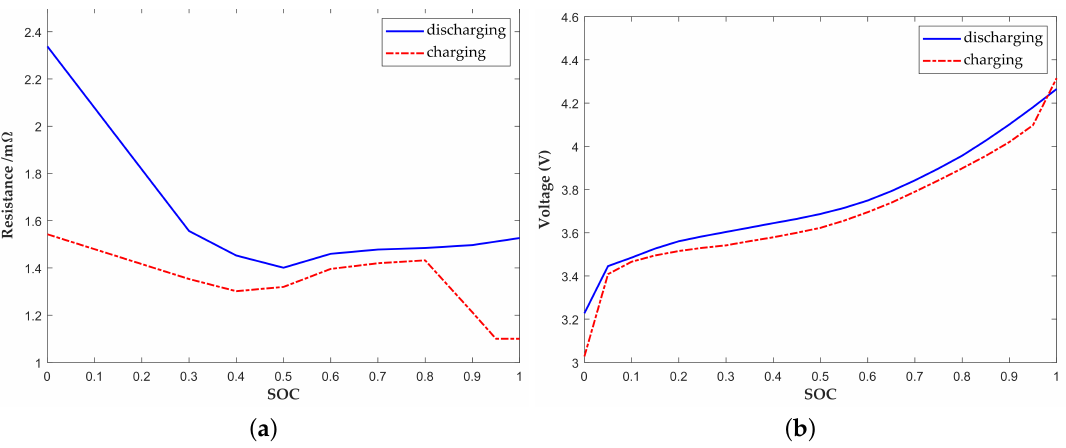
Figure 3. Battery parameters: ( a ) The relationship between V oc and state-of-charge (SOC) under charging or discharging status. ( b ) The relationship between R int and SOC under charging or discharging